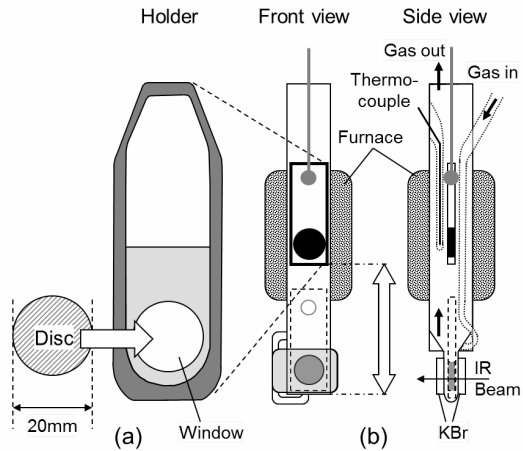
Figure 11. Configurations of ( a ) the sample holder and ( b ) the IR cell equipped with a